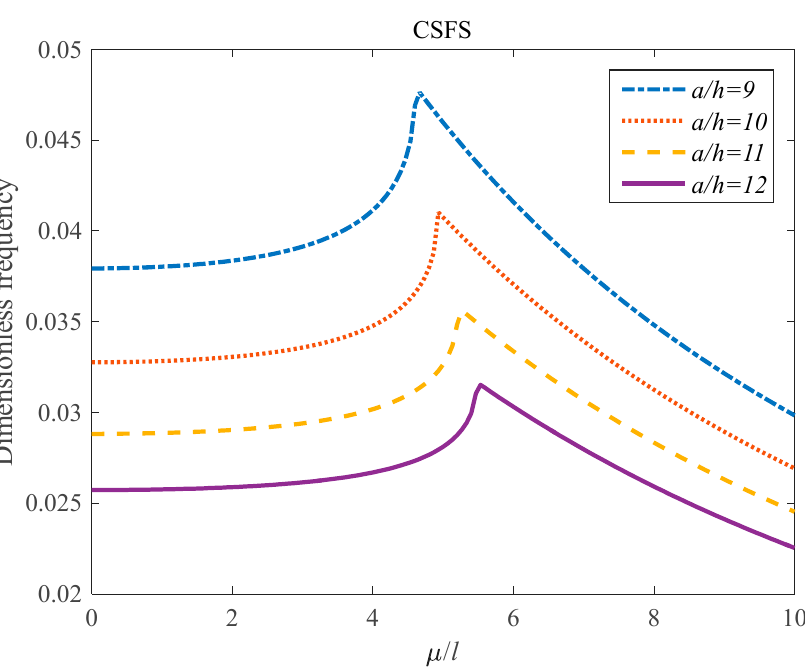
Figure 4. The influences of a/h and μ /h on the frequency for the CCCC boundary conditions with a/b = 5, l=h/5, ∆ T=100K, NL = 10, g_GPL= 0.5%, and GPL ‐ x.